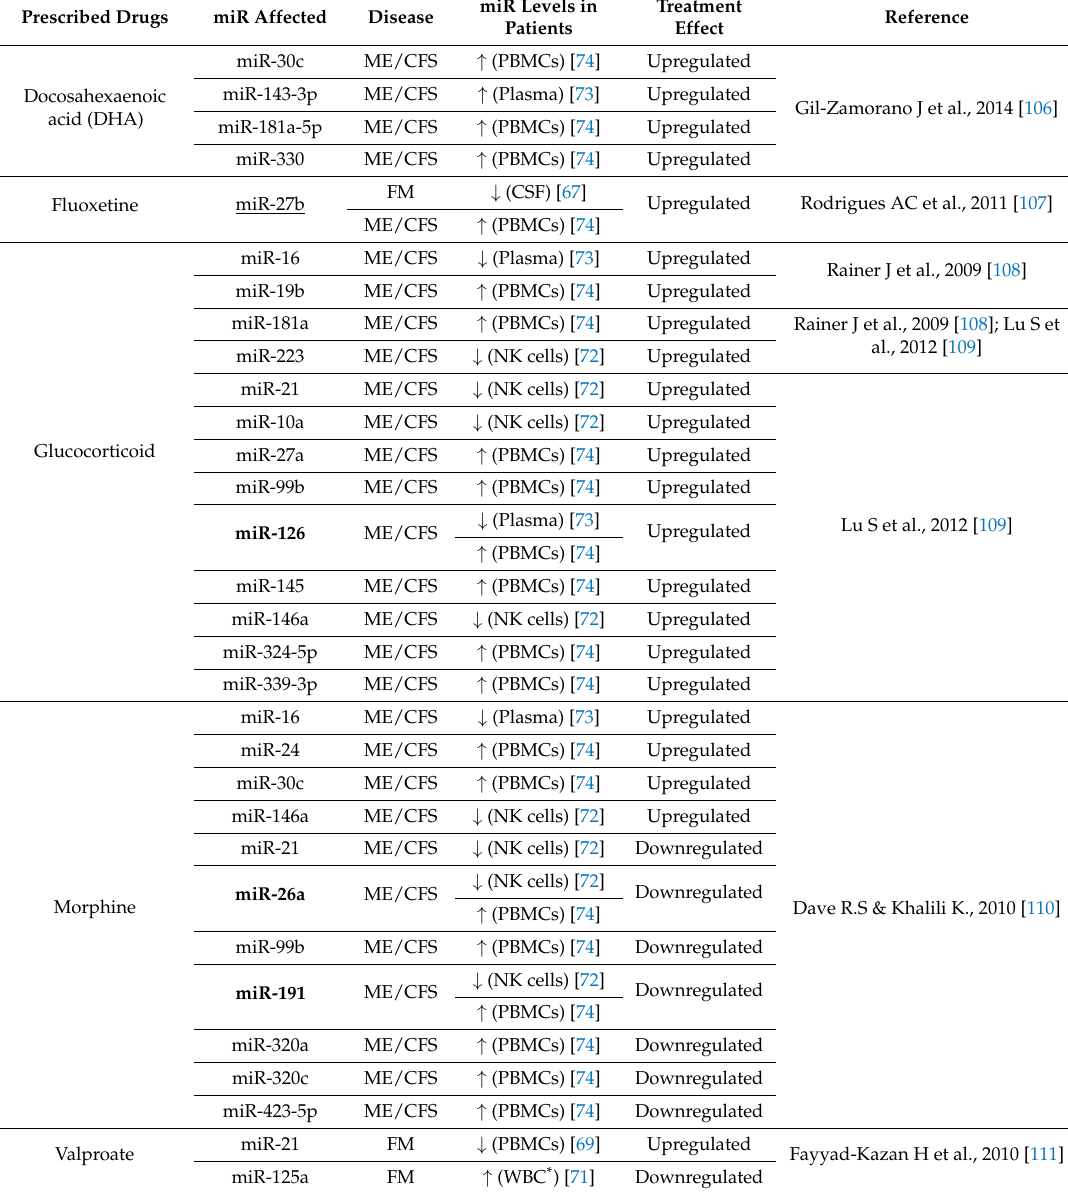
Table 5. Effect of FM and ME/CFS polypharmacy on miRNomes associated with